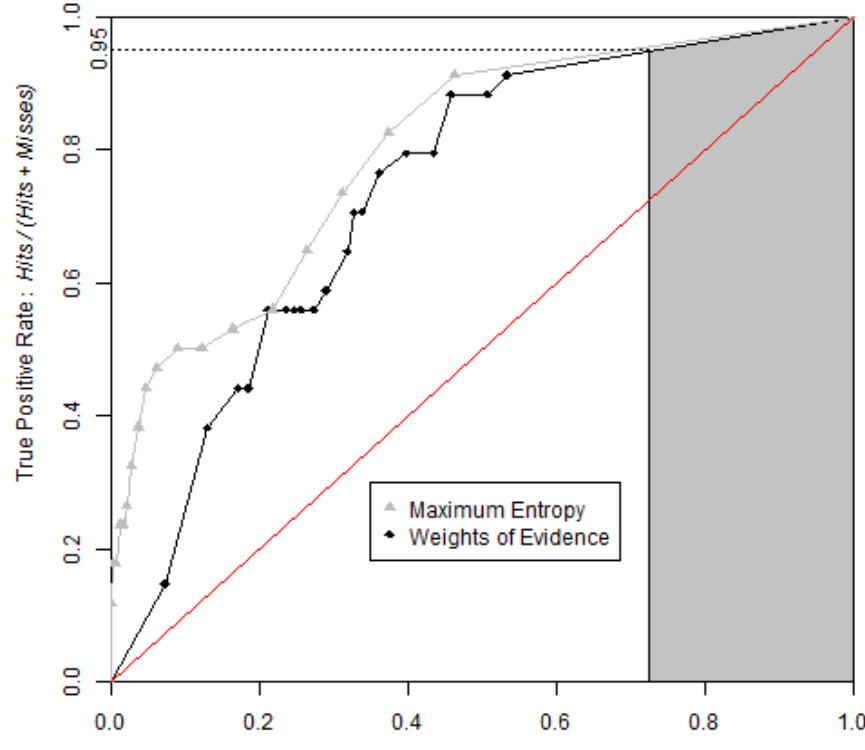
Figure 9. ROC curves obtained by WofE and MaxEnt methods. Grey shaded area represents partial AUC of WofE model between 0.95 and 1 on the True Positive Rate